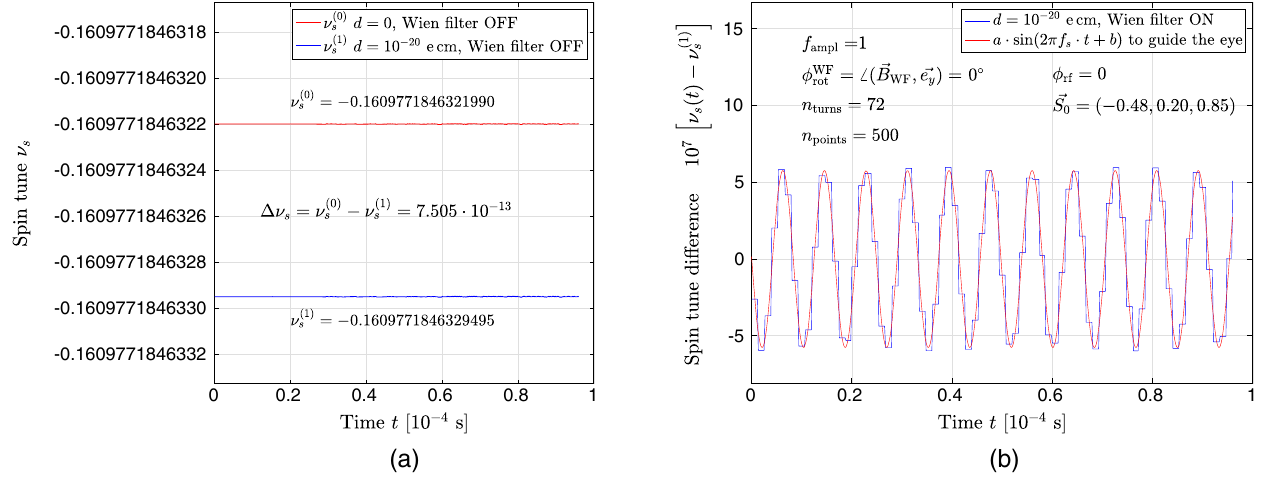
FIG. 14. The graph in panel (a) shows the spin tune in the machine, calculated using Eq. (93) for the conditions listed in Table I for d ¼ 0 (red) and d ≠ 0 (blue) and rf Wien filter switched OFF. Panel (b) shows the time dependence when the rf Wien filter is switched ¼ 1 . The red curve indicates the spin oscillation frequency f ON in EDM mode with f ampl ð t Þ − ν ð 1 Þ running spin tune difference ν s for each turn. It should be noted that the initial spin vector s (see Fig.